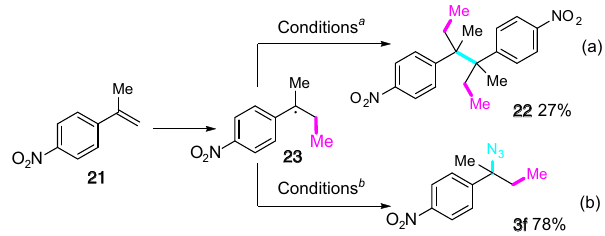
Fig. 6 Mechanistic divergence between methoxy methylation and azido methylation. a : 21 (0.2 mmol), Cu(BF 4 ) 2 (cid:129) 6H 2 O (0.2 equiv), L1 (0.3 equiv), DCP (4.0 equiv), Na 2 HPO 4 (0.2 equiv), MeOH (2.0 mL, c 0.1 M), 120 °C, 4 h; b : 21 (0.2 mmol), DTBP (0.8 mmol), LiN 3 (0.5 mmol), CuSO 4 (0.002 mmol, 0.1 equiv), L2 (0.06 mmol), t BuOH (2.0 mL, c 0.1 M), 120